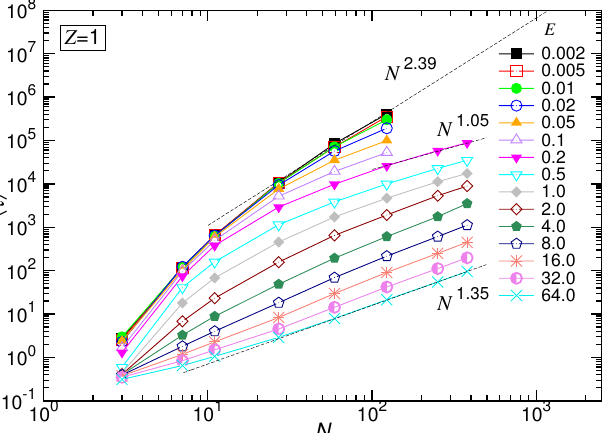
Figure 5. Mean translocation time (cid:104) τ (cid:105) as a function of the number N of the monomers transported in the monovalent salt solution. The strength of the driving field E can be read from the legend. The dashed lines indicate the three characteristic scaling behaviors.